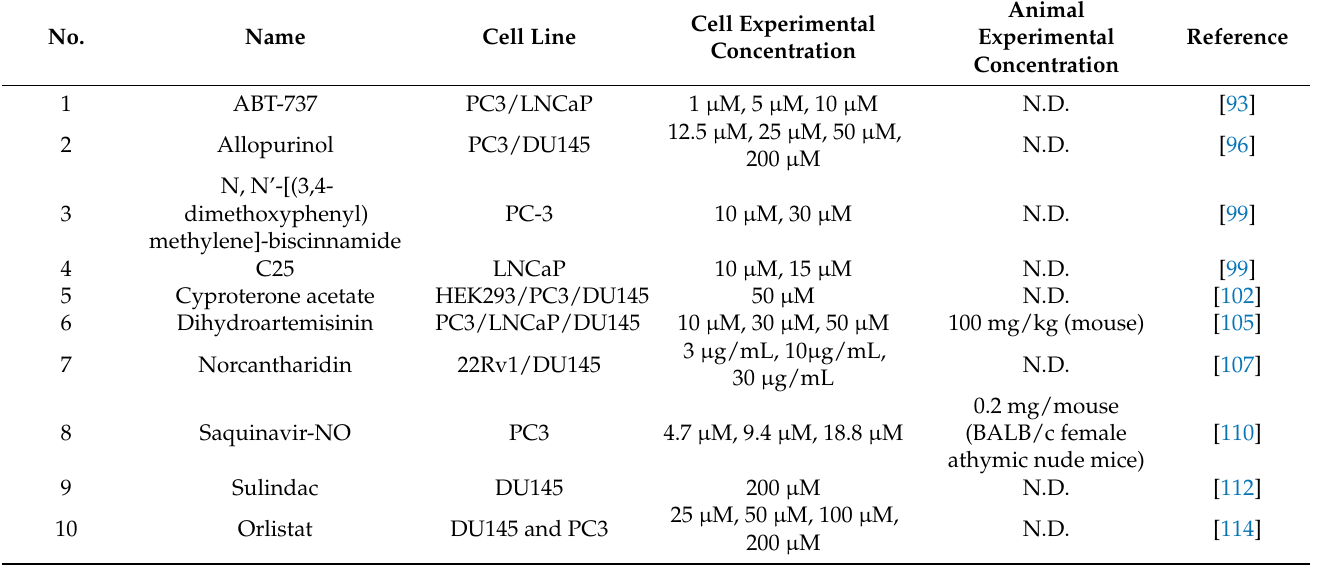
Table 3. Chemically synthesized compounds that suppress prostate cancer by enhancing the function of death receptor